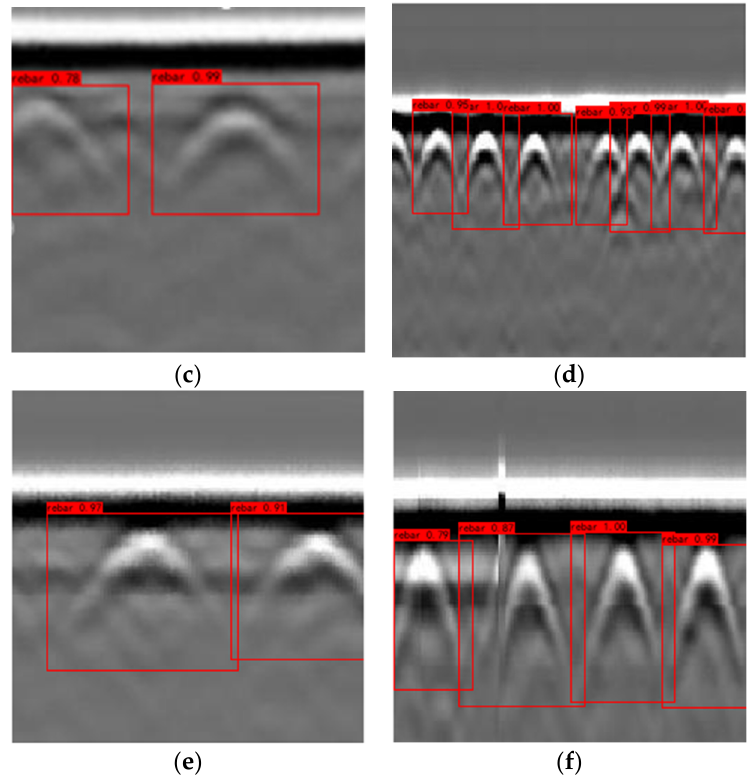
Figure 11. ( a – f ) Rebar detection examples of field GPR images using the trained Yolov4 model.